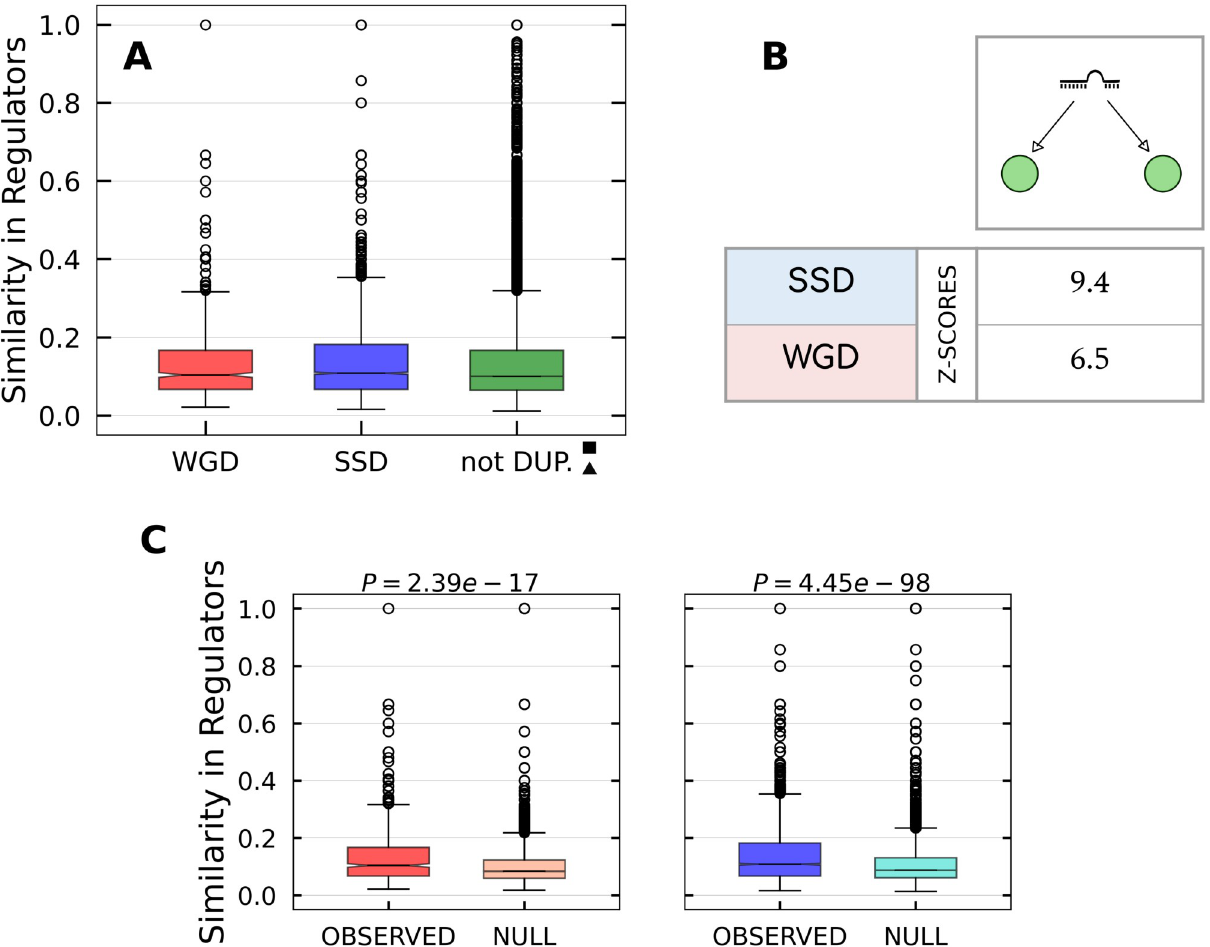
Fig 7. miRNA Λ motifs. (A) Similarity distributions for WGD, SSD and not duplicated target genes couples in the TarBase network. As indicated by the presence of the symbols explained in the Materials and methods section, the difference between SSD and WGD distributions is not statistically significant, while both of them are significantly greater that the similarity distribution of non duplicated genes. (B) Z-scores measuring the enrichment of the Λ motif with respect to the null model. (C) Pairwise comparison between each real similarity distribution and the null distribution for the respective duplication